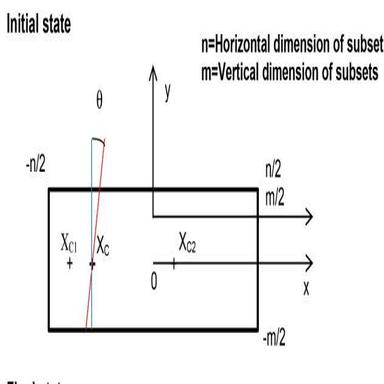
Principle of the 2P-DIC, decomposition of a subset in two parts.